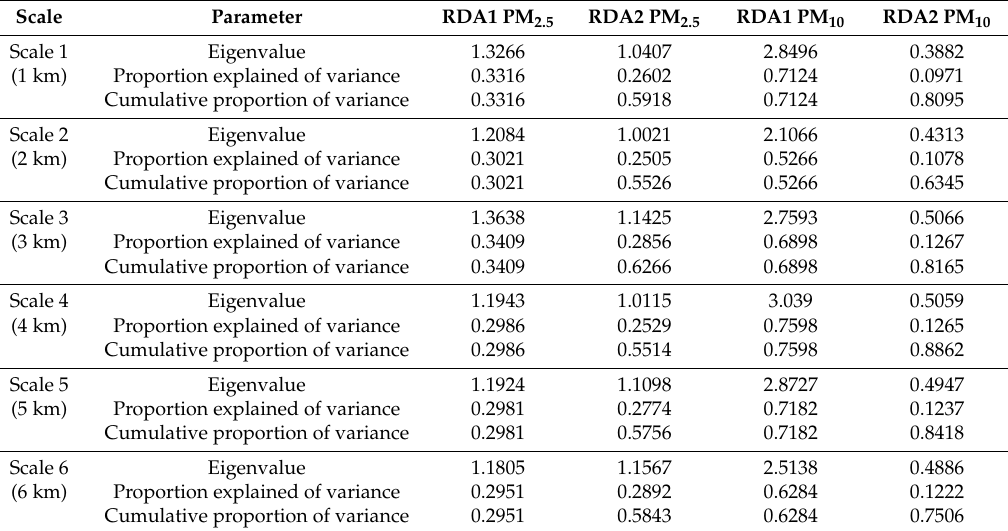
Table 2. Redundancy analysis of PM 2.5 and PM 10 concentration on multiscale plots.